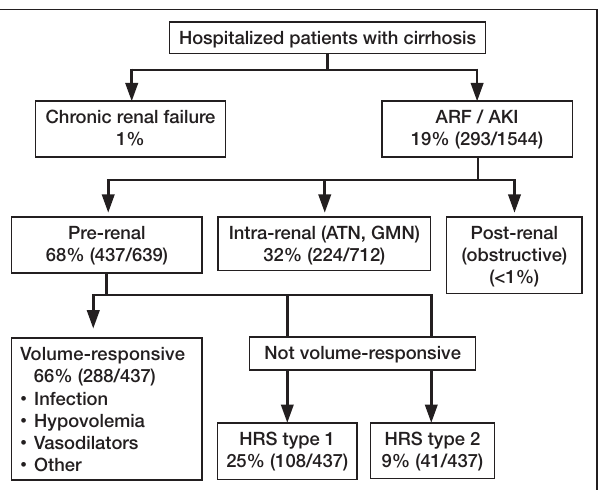
Figure 1) Types of renal impairment in hospitalized patients with